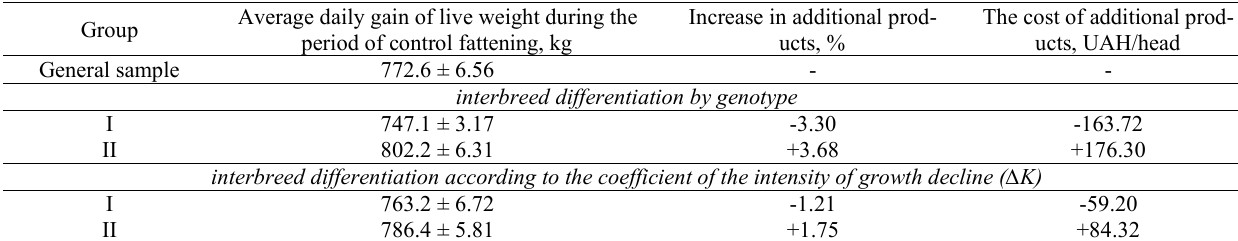
Economic efficiency of research